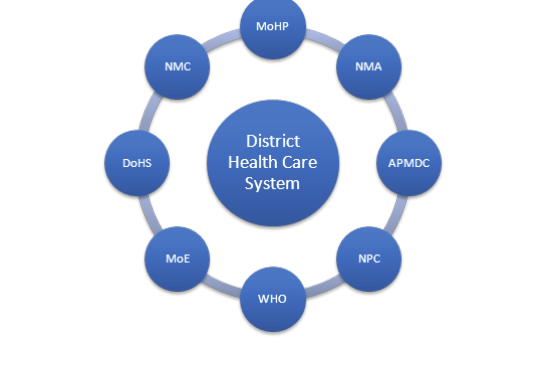
Figure 1. Key Stakeholders for Strengthening District Health Care